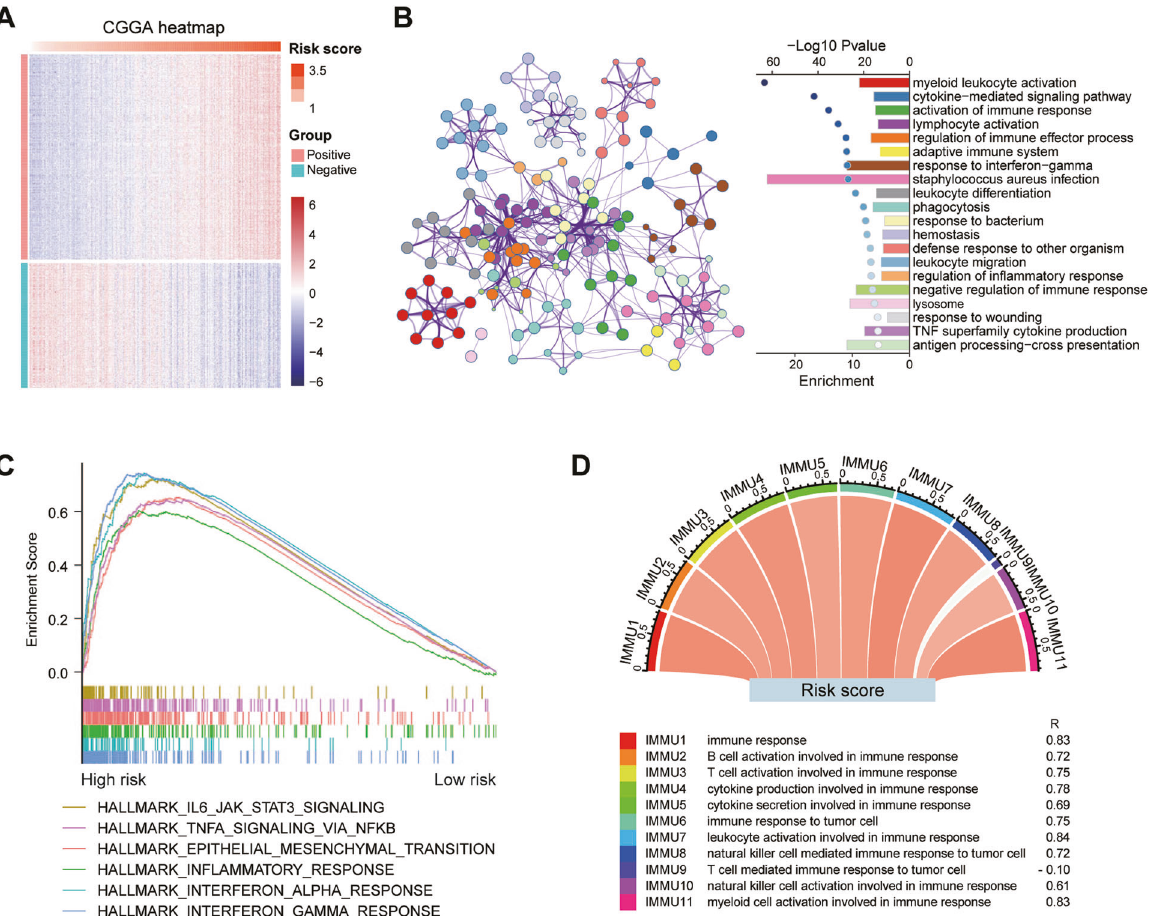
Fig. 5 GO and GSEA annotation of genes associated with risk score in the CGGA dataset. A Heatmap of genes that are positively and negatively associated with risk score. B Functional enrichment of the positive related genes with the risk score by Metascape. C Enriched gene sets in HALLMARK collection by samples with high-risk score. D The correlation coef fi cient between risk score and different immune function scores. IMMU9 represents a negative correlation and other IMMNUs represent a positive